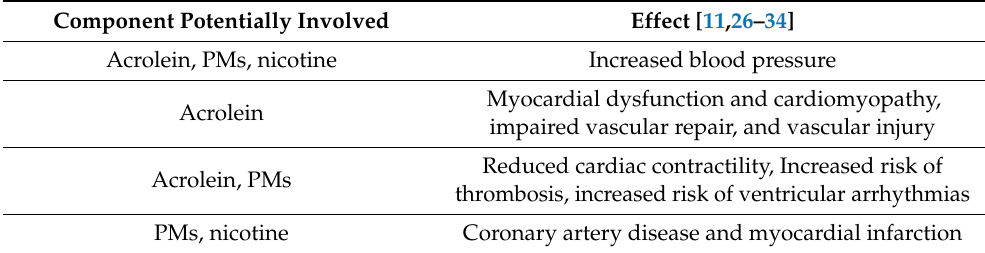
Table 4. Potential vascular effects of e-cigarette components.